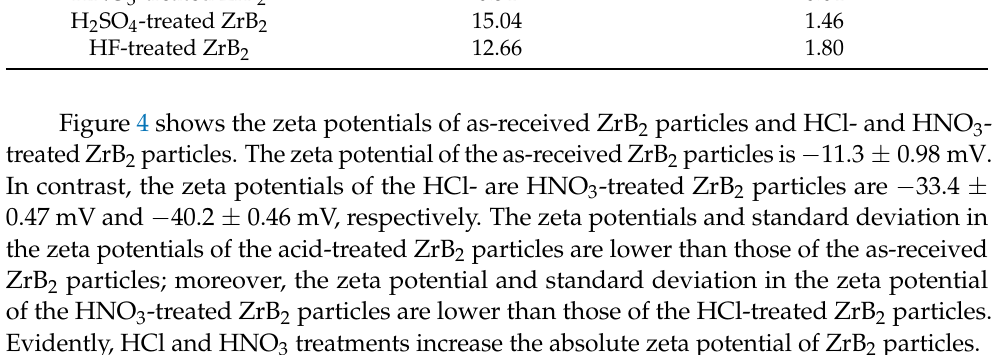
treated ZrB 2 particles. The spectrum of the as-received ZrB 2 particles shows peaks at 3221 cm − 1 and 1477 cm − 1 corresponding to O–H stretching vibrations and C–H bending vibra- tions, respectively. The spectra of the HCl- and HNO 3 -treated ZrB 2 particles are similar to